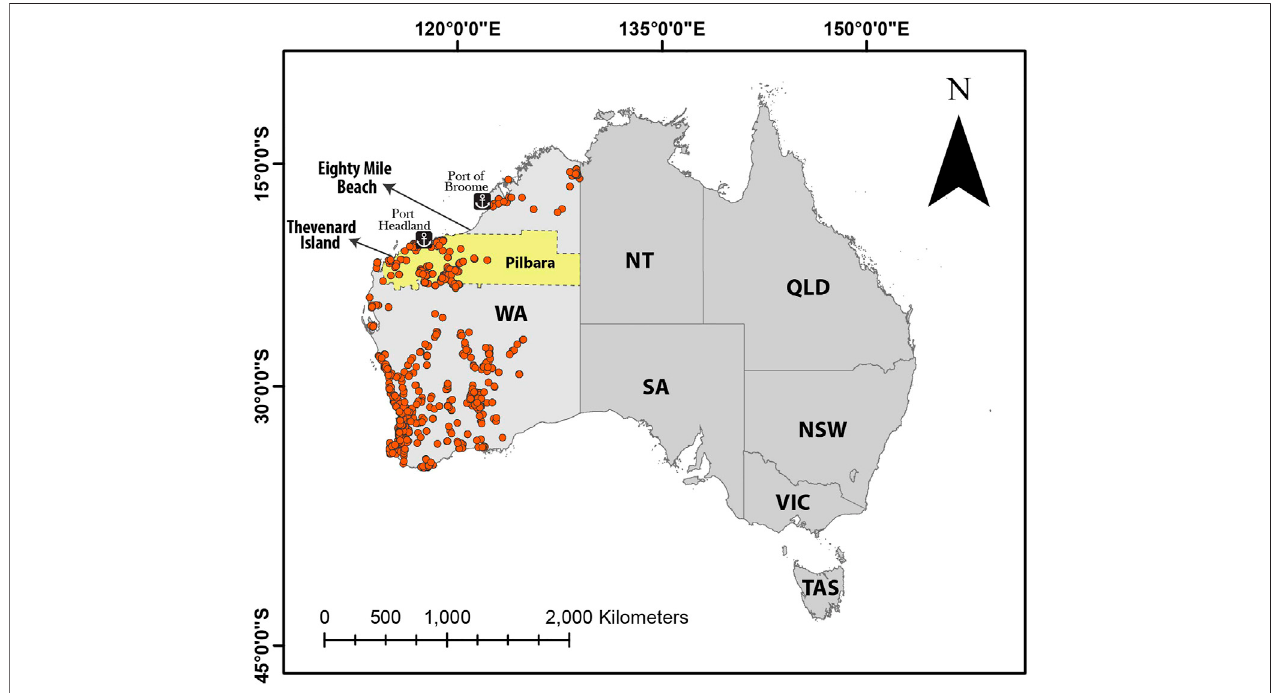
FIGURE 1| Flatback monitoring sites in Thevenard Island and Eighty Mile Beach; orange circles representoperational mines in WesternAustraliaas ofSeptember 2020; the Pilbara region is highlighted. Data obtained as shape fi le from MINEDEX (DMIRS-001) database (Department of Mines Industry Regulation and Safety, 2020).